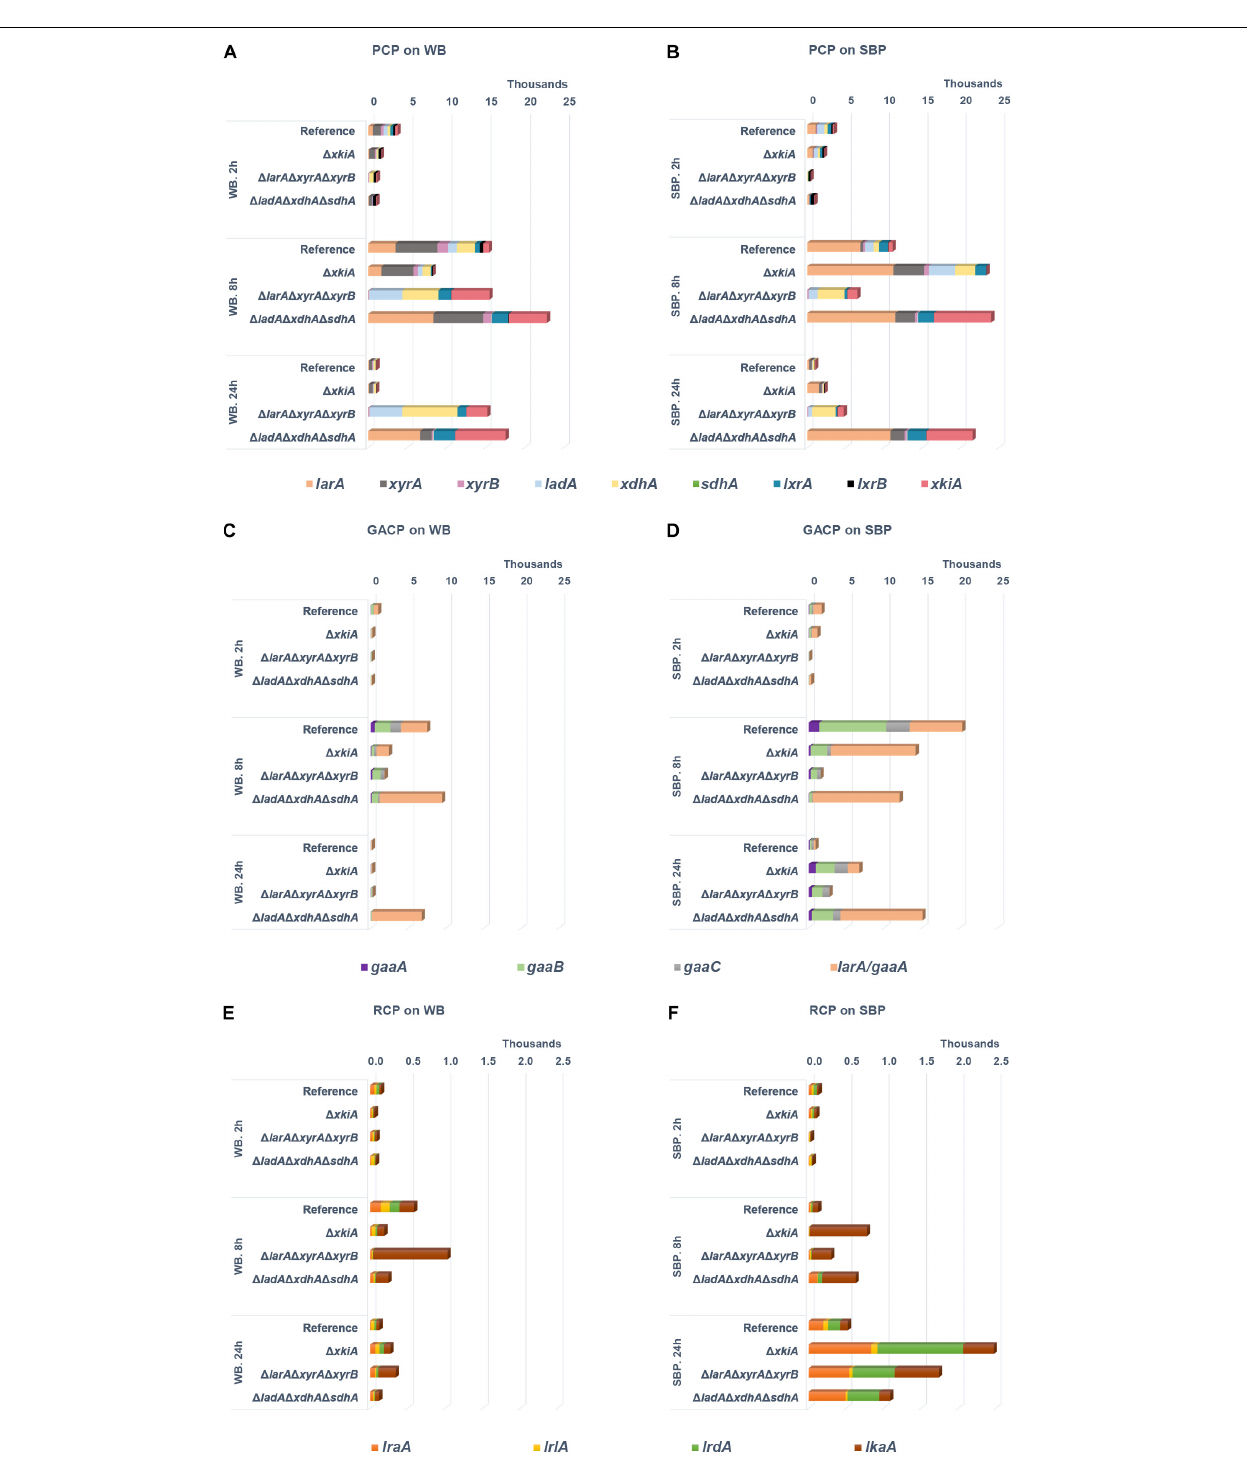
Frontiers in Bioengineering and Biotechnology |